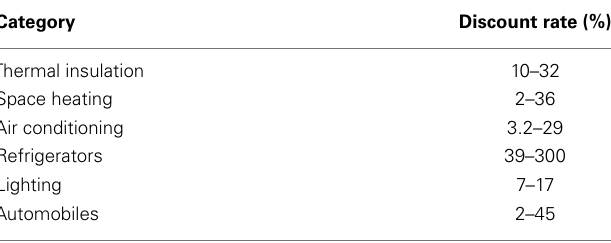
Table 1 | Estimated product-specific implicit discount rates p.a